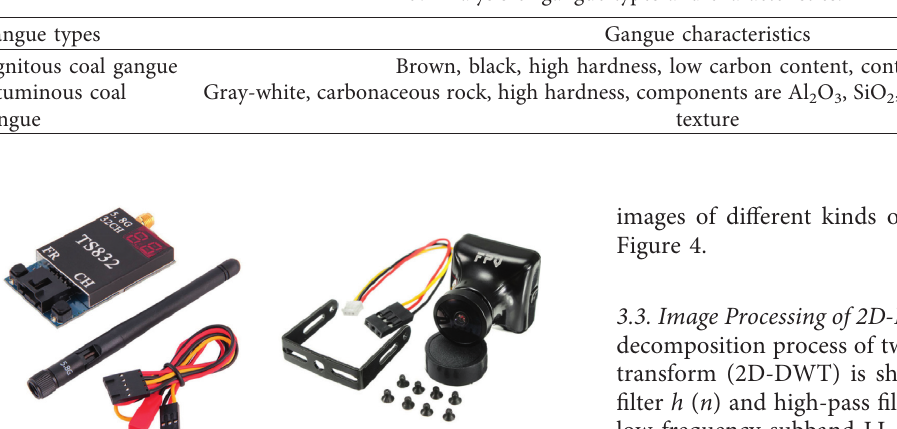
Table 3: Analysis of gangue types and characteristics.